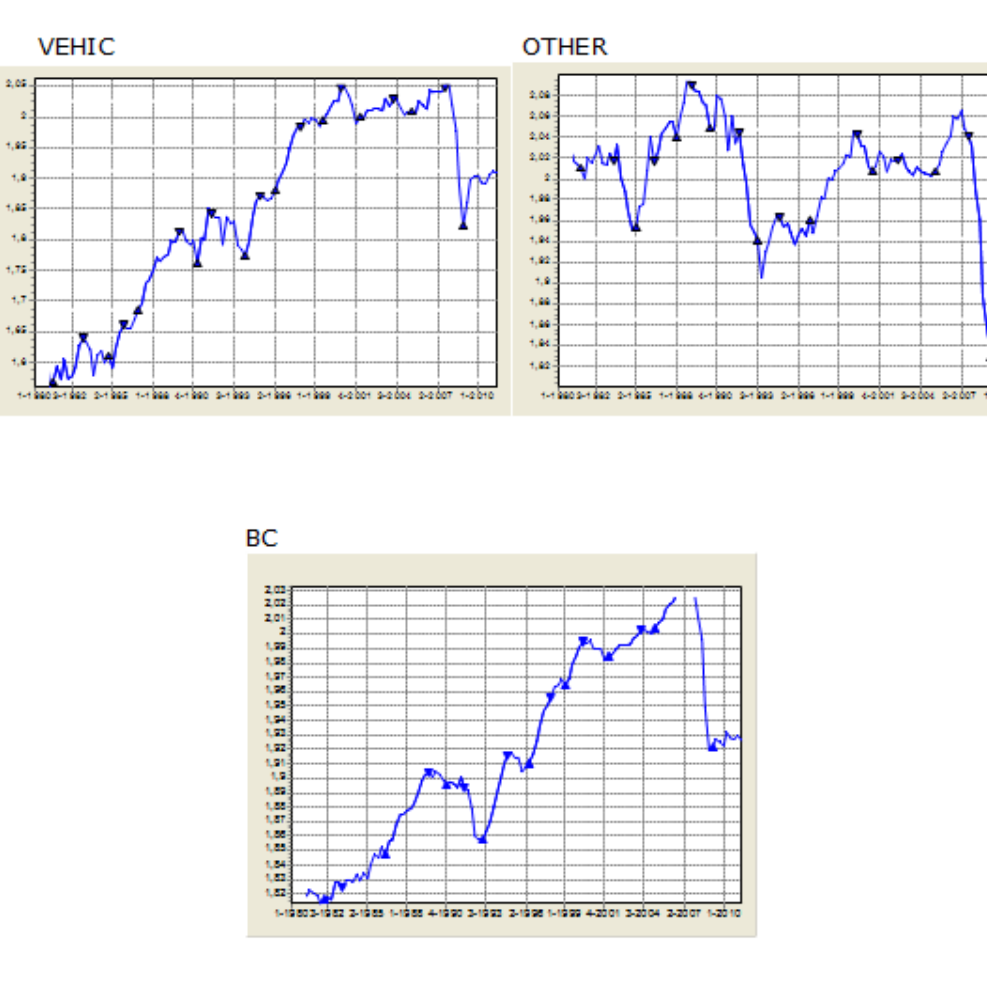
In the figure:  peak ;  trough (Eurostat, elaborated with the program BUSY) Figure B.1 Turning points (ordinate axis: log original series)